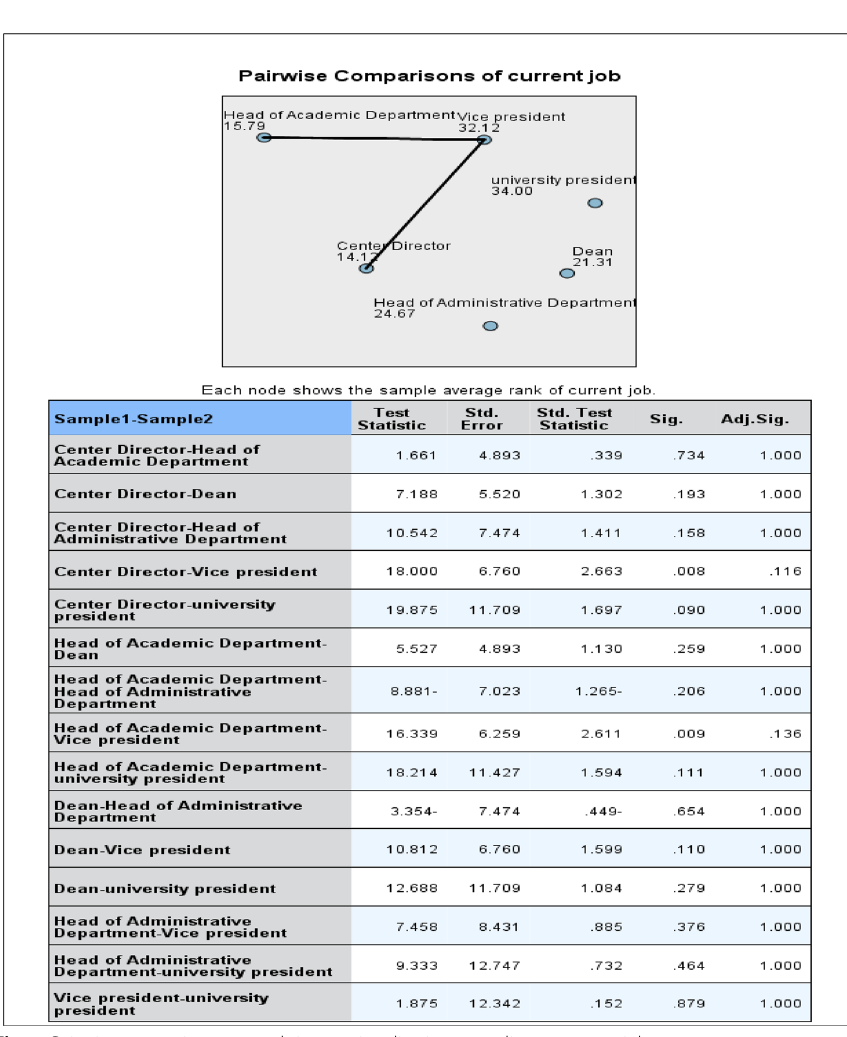
Fig. 4 Pairwise comparisons towards internationalization according to current